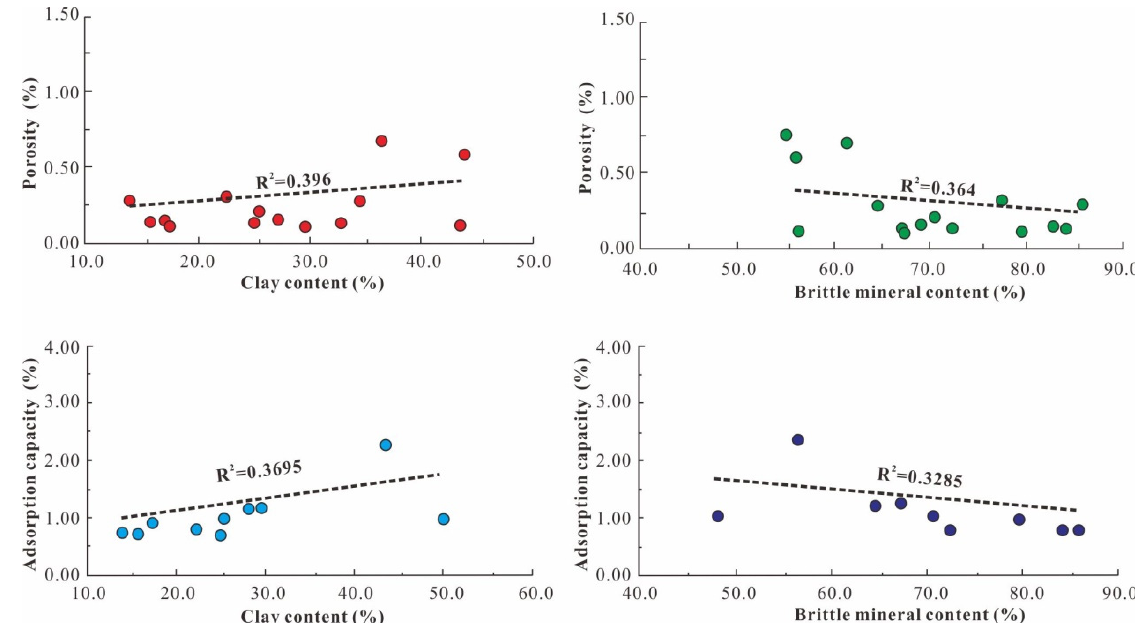
Figure 9. Relationship between mineral content, shale porosity, and adsorption capacity.